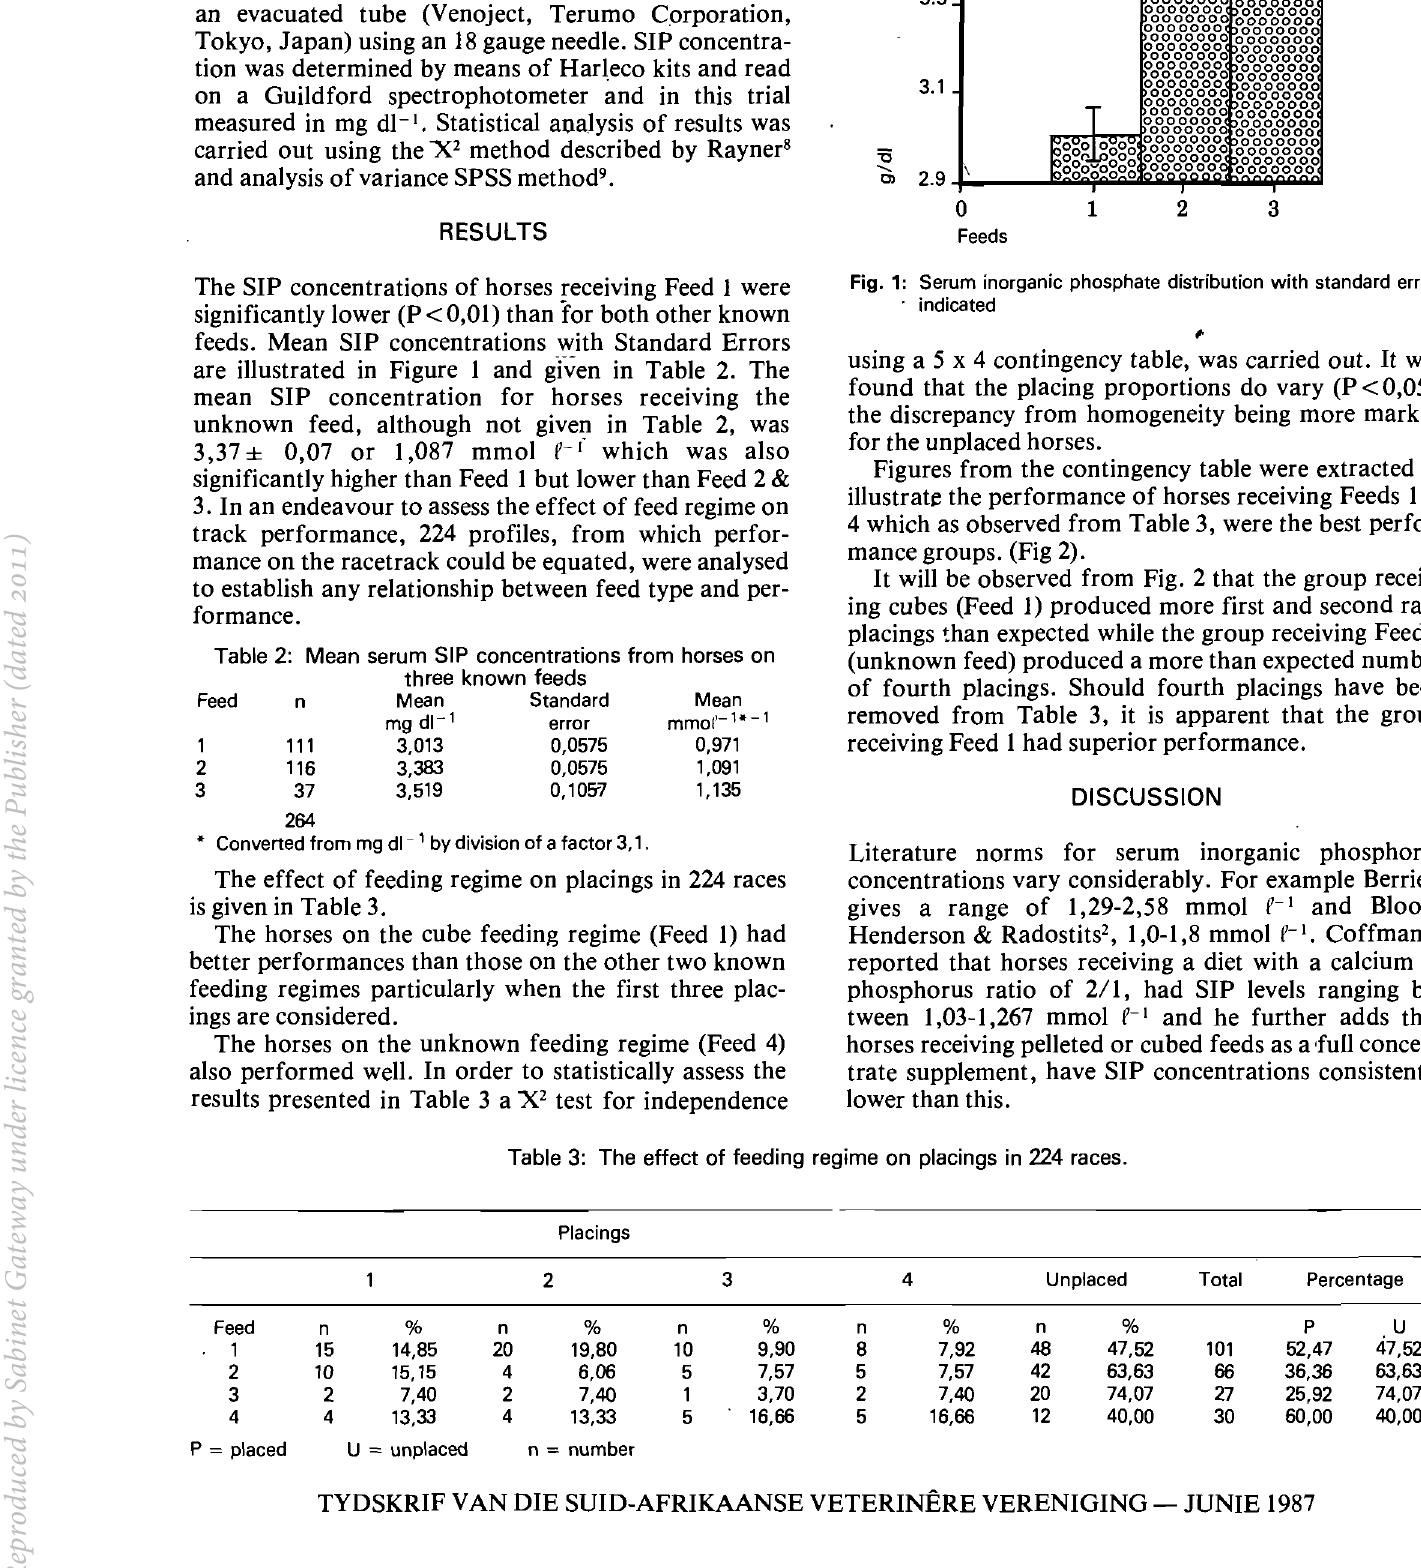
Fig, 1: Serum inorganic phosphate distribution with standard errors indicated